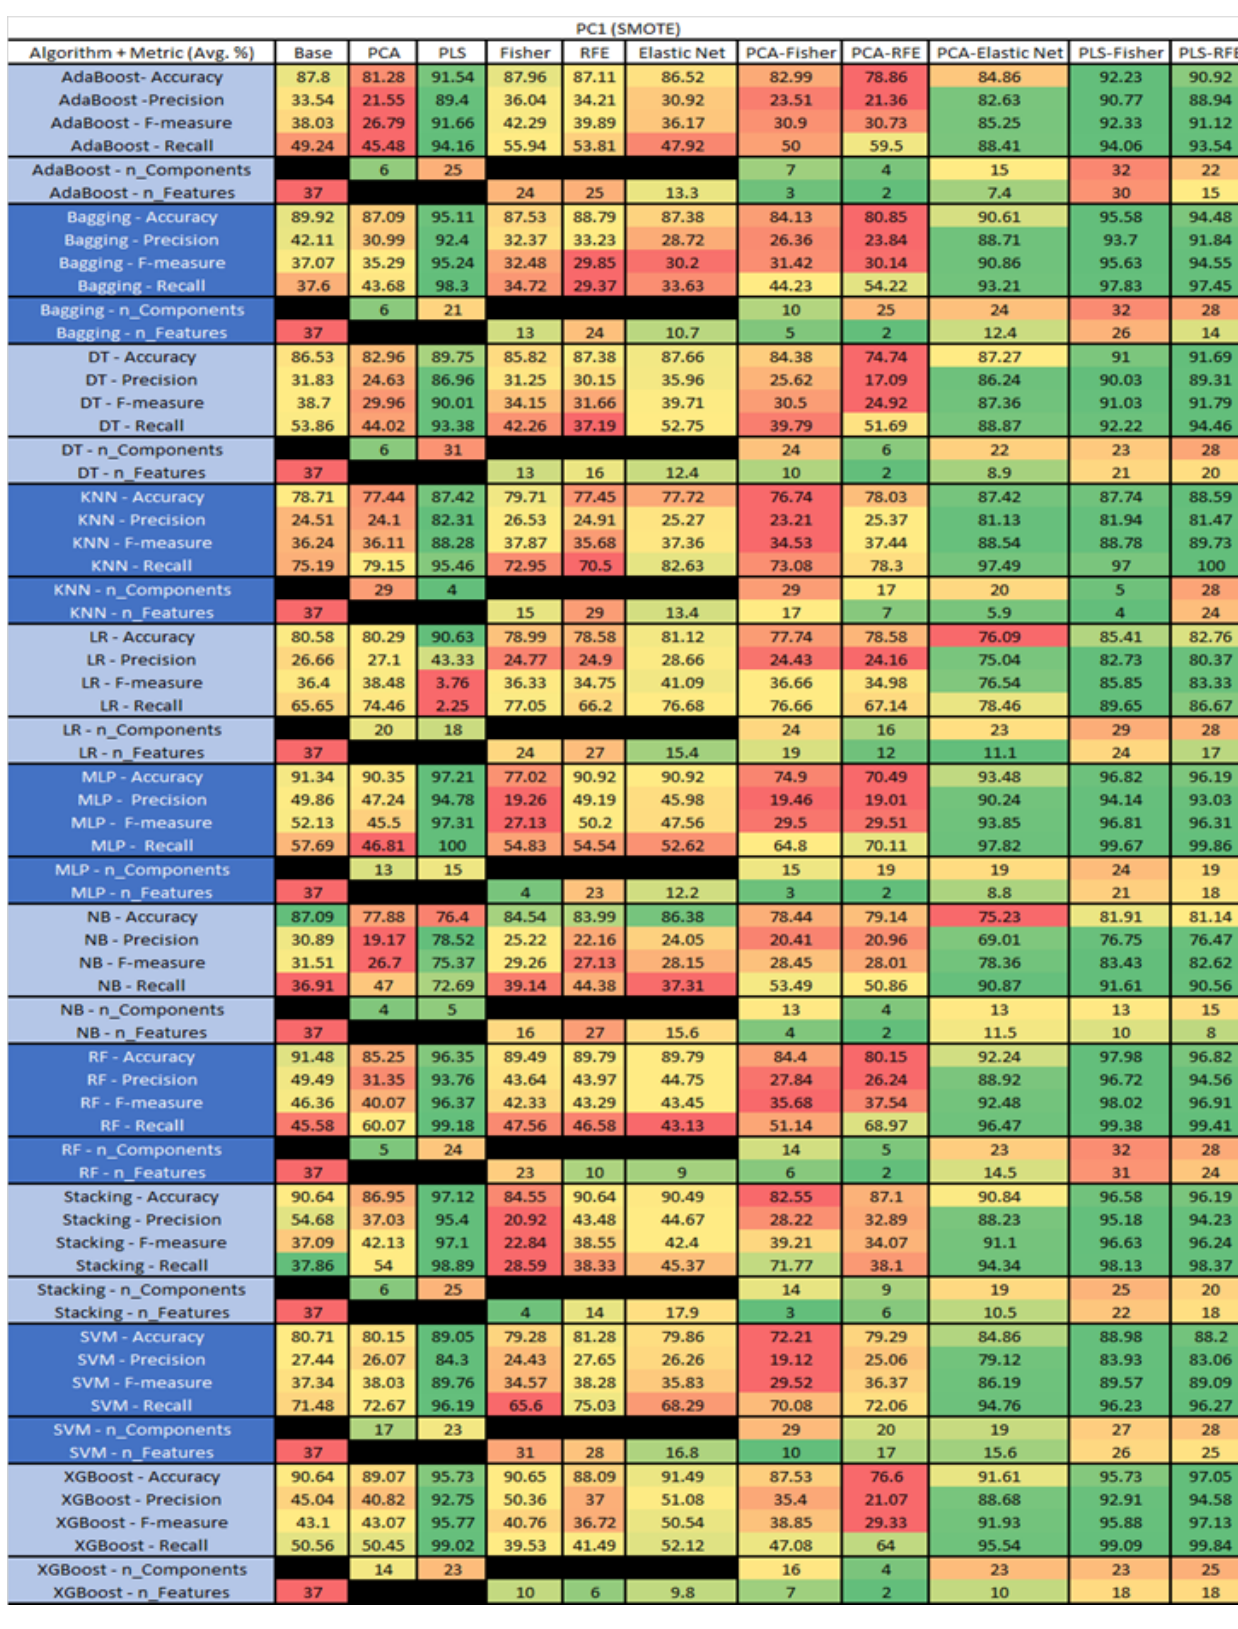
Figure 41. PC1 SMOTE NASA MDP Results Data